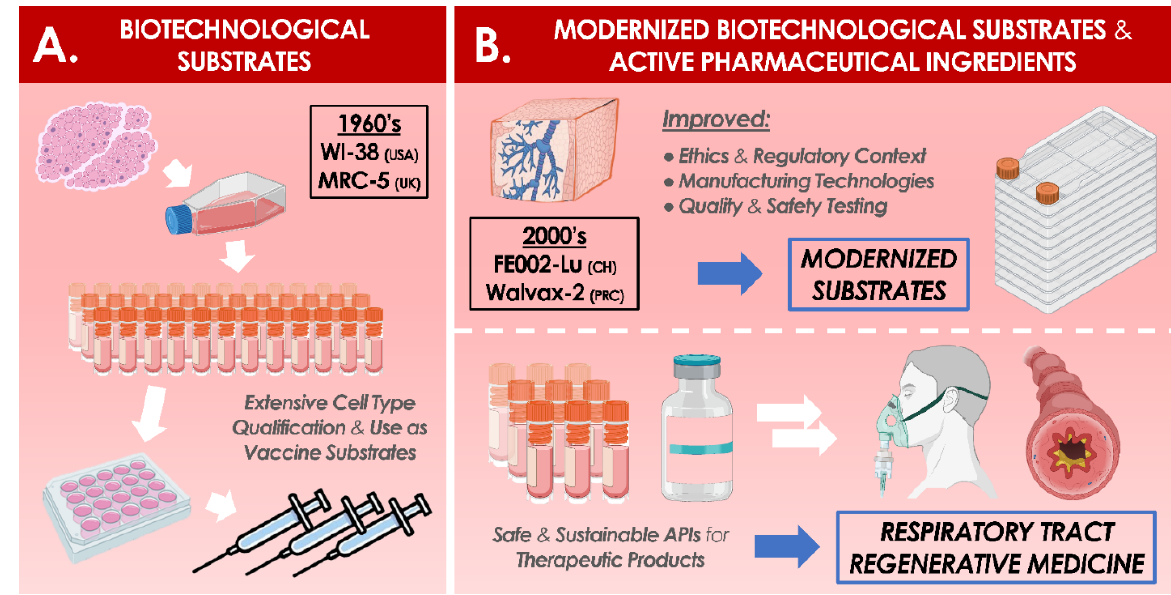
Figure 3. Schematic technical overview of the evolution of primary progenitor-cell applications since the 1960s. In addition to the continued use as renewed biotechnological substrates ( A ), modern frameworks consider clinical-grade primary progenitor cells as APIs in homologous allogeneic regenerative medicine ( B ). The provided illustrated example is based on the historical biotechnological use of the WI-38 and the MRC-5 cell sources by the vaccine industry and on the current considerations for dual valorization options for modern lung-tissue-derived primary progenitor-cell sources (e.g., FE002-Lu cell type). API, active pharmaceutical ingredient; CH, Helvetic Confederation; PRC, People’s Republic of China; UK, United Kingdom; USA, United States of America.